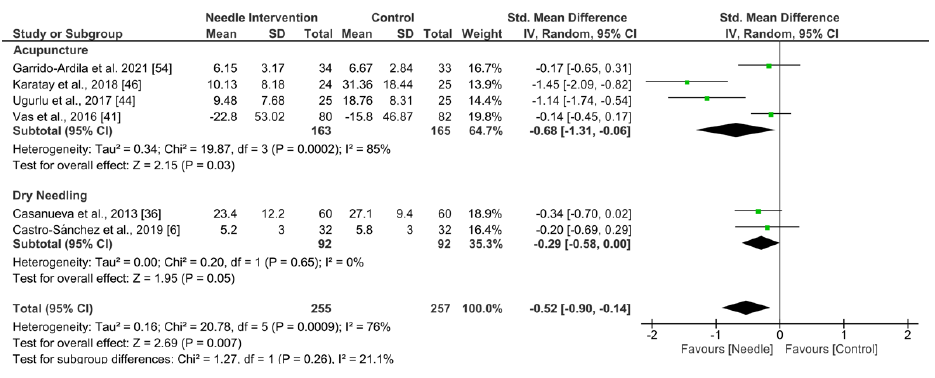
Figure 11. Forest plot for Depression.